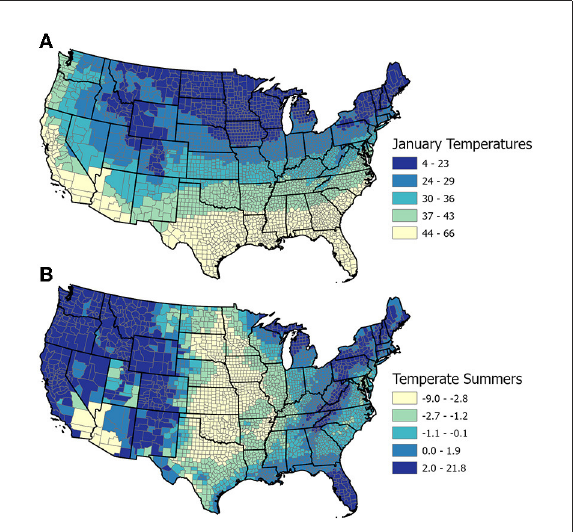
FIGURE2 (A) Mean january temperatures in degrees fahrenheit, 1991–2020 ( Abatzoglou, 2012). Colder winters are in deeper shades of blue, while the warmest winters are in white. (B) Temperate summers (the negative residual of July over january temperatures), 1991–2020 (calculated from Abatzoglou, 2012). Areas in deeper shades of blue have relatively cooler summers, while those in pale blue and white have relatively hot summers. Counties are grouped and color-coded in